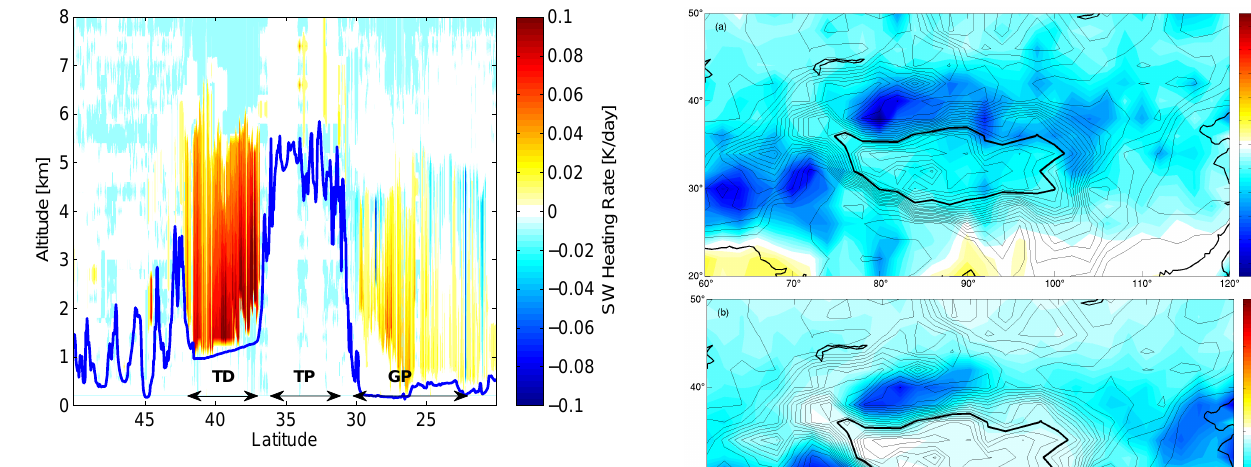
Fig. 7. Effect of albedo variations on aerosol forcing ( 1 alb ) in SW heating rates throughout the vertical extent of the atmosphere in K/day.